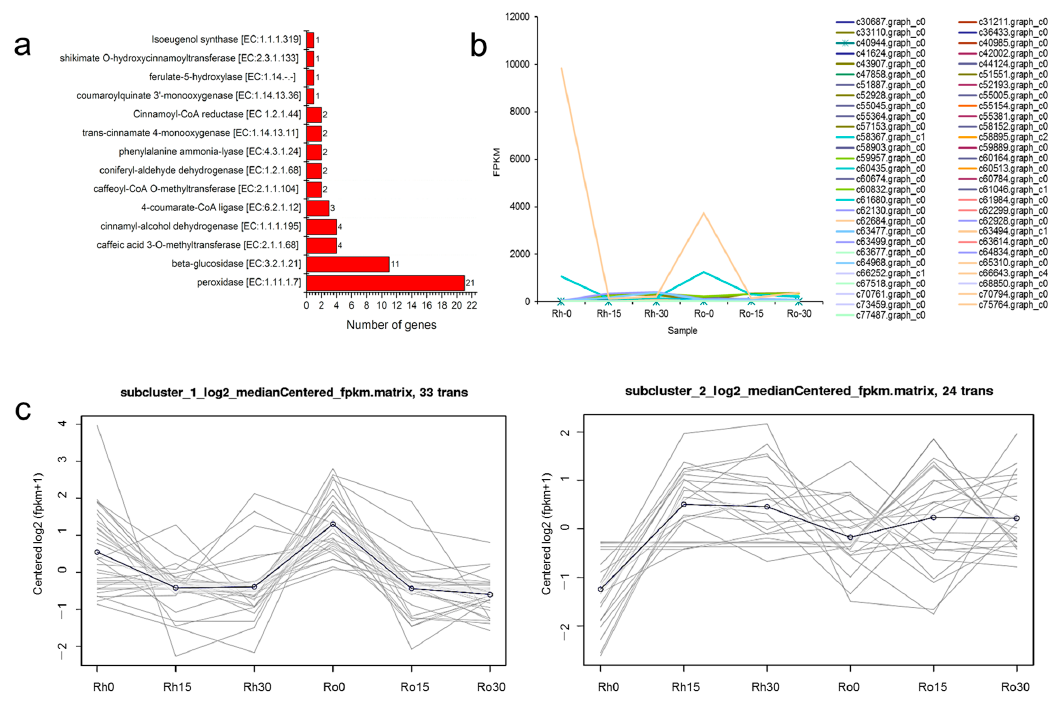
Figure 5. Expression profiles of 57 DEGs related to phenylpropanoid biosynthesis. ( a ) Number of DEGs in the phenylpropanoid biosynthesis pathway, ( b ) FPKM value of 57 DEGs, ( c ) clusters analysis of 57 DEGs.